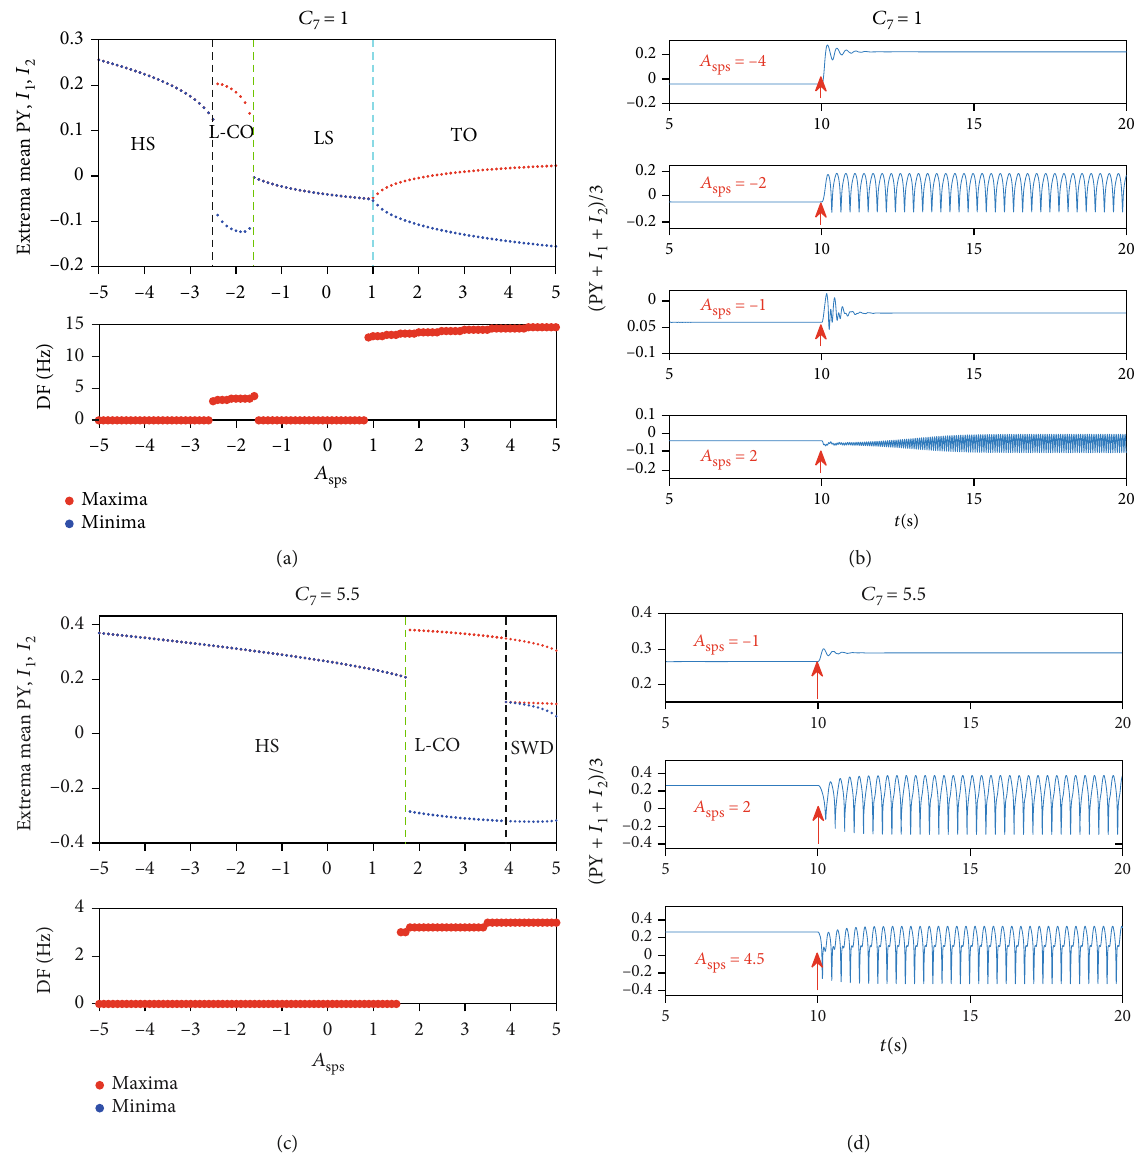
Figure 8: The bifurcation diagram (upper panel of (a, c)), their corresponding dominant frequencies (lower panel of (a, c)), and the speci fi c time series (b, d) after single-pulse stimulation acting on RE at t = 10 s when the system is in low saturated state (a, b) and high saturated state (c, d) originally. Similarly, HS (high saturated state), l-CO (low-frequency clonic oscillations), LS (low saturated state), TO (tonic), SWD, and the strength of stimulation ( A sps ) are indicated by text labels in each fi